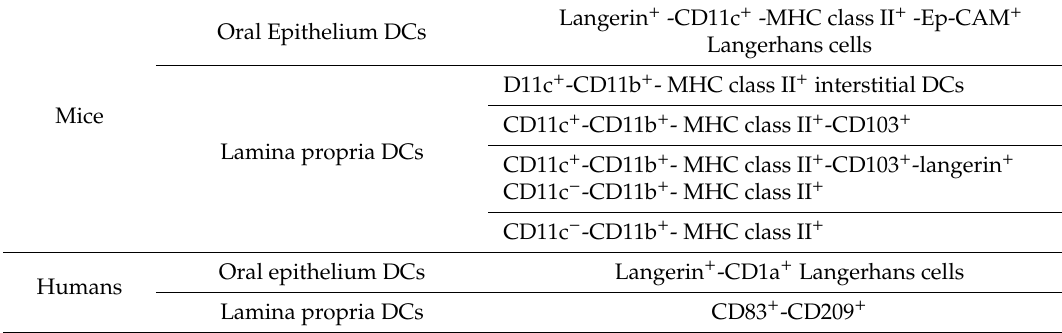
Figure 2. DC subsets in human periodontal tissue. Langerhans cells (LC) infiltrate the oral epithelium (EP). The lamina propria (LP) is infiltrated by mature DCs, where they form oral lymphoid foci (OLF) with CD4 + T cells resulting in T cell activation and cytokines secretion. Table 1. DC subsets in periodontal tissues of mice and